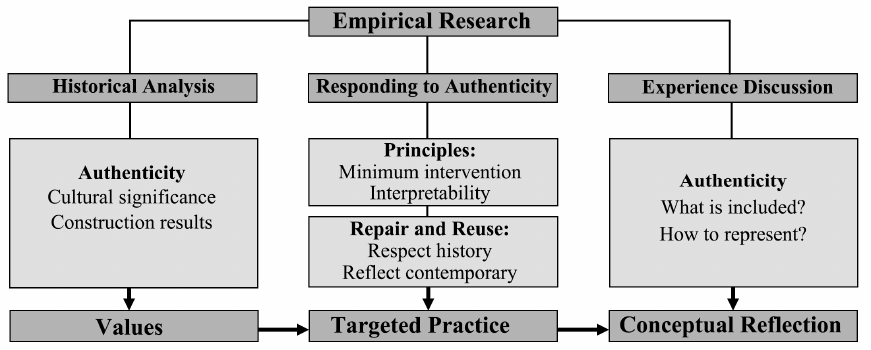
Figure 2. The methodological framework of this study. Picture by X.X.